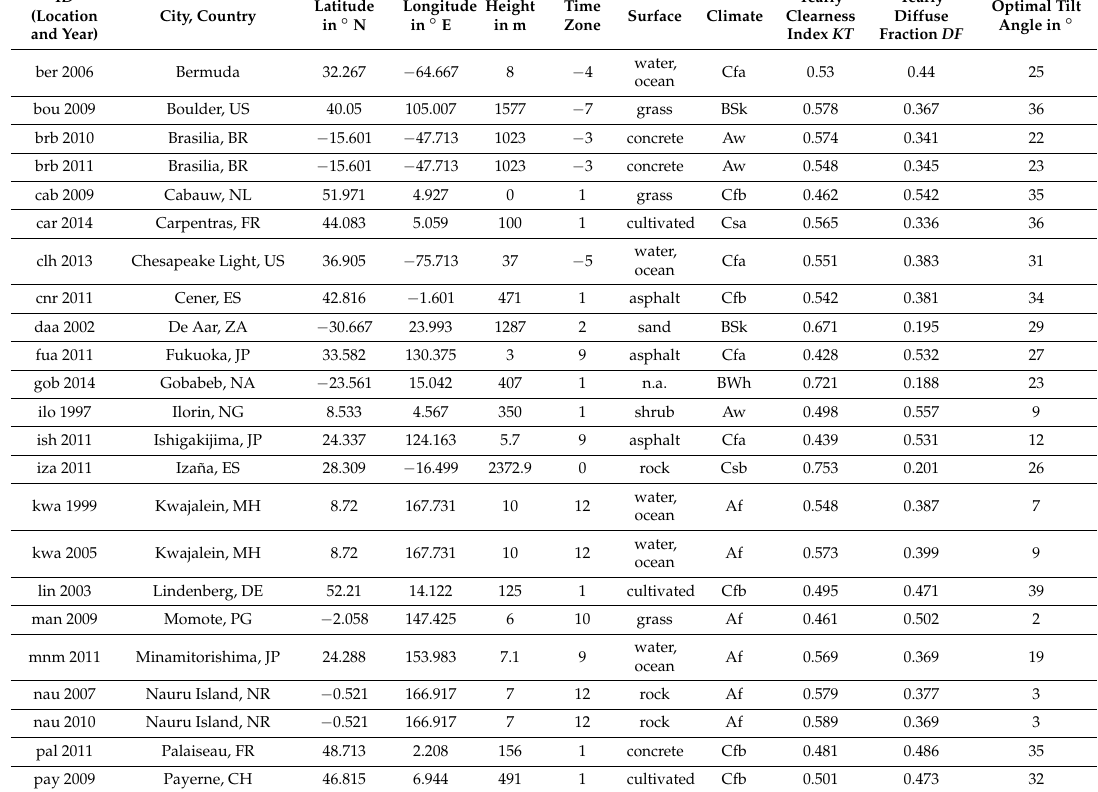
Table 1. Overview of the selected measurement datasets. It comprises 30 locations of the Baseline Surface Radiation Network (BSRN) [1], spread over the whole globe between 60 ◦ North and South. Height above sea level, surface, topography and climate zones (according to Köppen [2]) show a high level of variation. The optimal tilt angle for each location is determined according to Section 2.3.